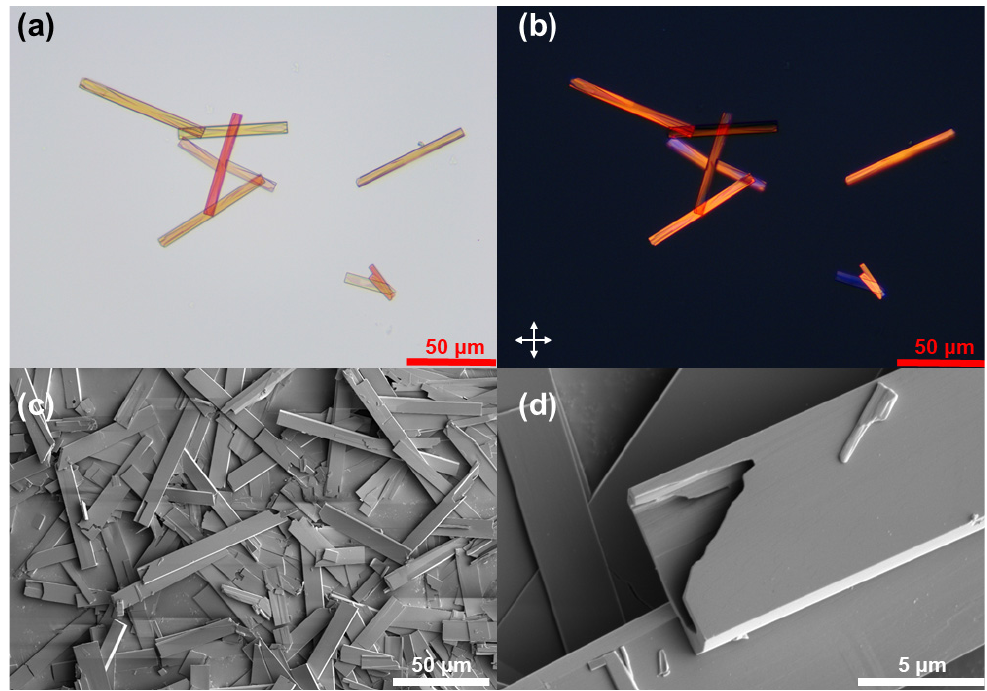
Figure 2. ( a ) The optical microscopy image of APE-TCNB hollow cocrystals; ( b ) the cross-polarized microscope image of APE-TCNB hollow cocrystals; ( c ) the SEM image of APE-TCNB hollow cocrystals; ( d ) the SEM image of a fractured APE-TCNB hollow cocrystal shows the interior structure. Table 1. The influence of surfactant type and temperature on crystal morphology.